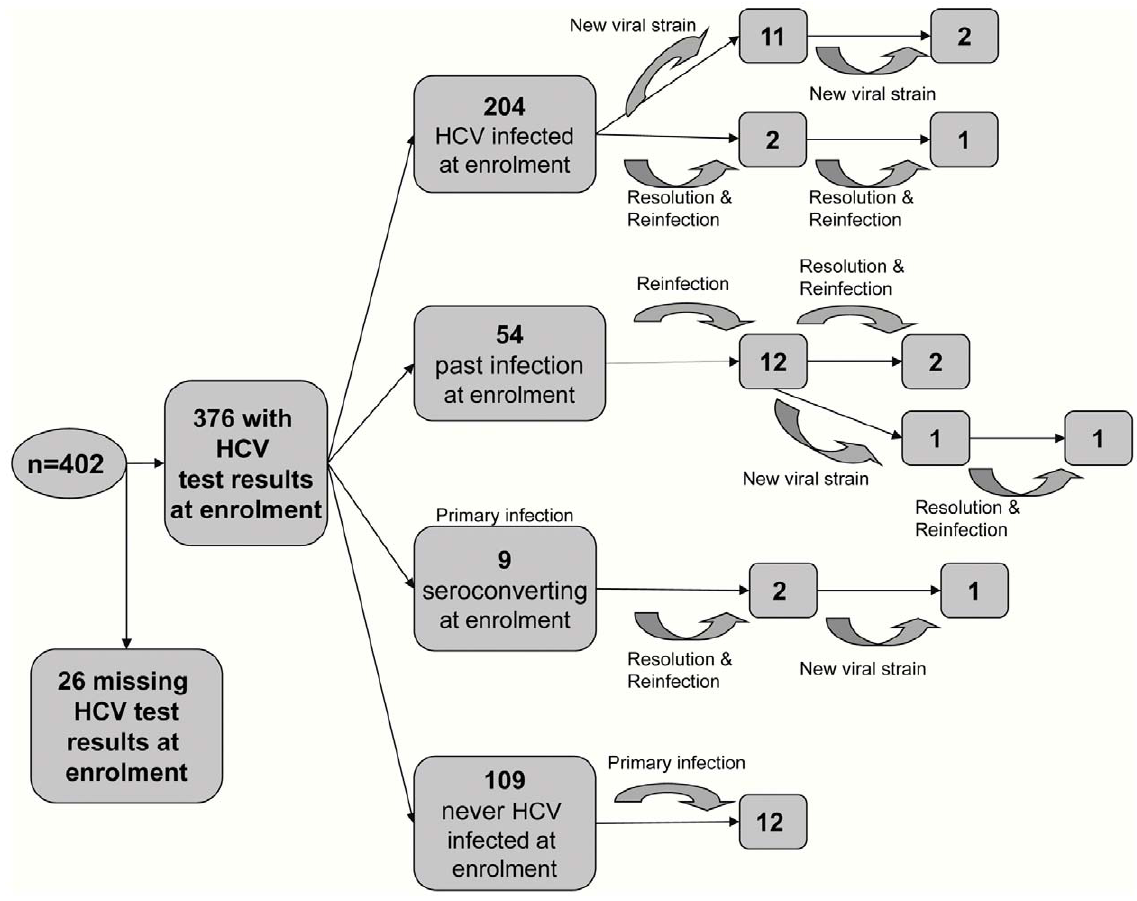
Figure 1. HCV primary infections, reinfections and changes in viral sequence by HCV status at study entry. HCV test results: anti-HCV and qualitative HCV RNA results. Those with missing results could not be bled or had indeterminate results; HCV infection at enrolment: anti-HCV positive and positive HCV RNA test (HCV RNA limit of detection: 50 IU/mL); past HCV infection at enrolment: positive anti-HCV test and negative HCV RNA test at the first study visit; seroconverting at enrolment: anti-HCV negative and positive HCV RNA test at the first study visit (indicating very early infection); never HCV infected at enrolment: negative anti-HCV test and negative HCV RNA test at first study visit. Participants with newly acquired primary HCV infection were defined by either: (a) a positive HCV RNA test and negative anti-HCV test at the first study visit (that is, seroconverting at enrolment); or (b) a negative HCV RNA test and negative anti- HCV test at their first study visit (that is, never infected at enrolment) and a subsequent positive anti-HCV/HCV RNA test during follow-up. Participants were defined as having a newly acquired reinfection if they tested HCV RNA negative on two occasions (at least 28 days apart) and subsequently tested HCV RNA positive; or tested HCV RNA positive and subsequently tested HCV RNA negative on one occasion, then tested HCV RNA positive, and the sequence distance between the two HCV RNA positive tests was at least 4% in the core region (331 nucleotides). Participants were defined as having a new viral strain if they did not satisfy the definition of reinfection because they had no intervening negative test but had two consecutive HCV RNA positive tests with sequence distance at least 4% in the core region (331 nucleotides). The methodology used to determine the 4% cut-off is described in the Materials and Methods section (definition 6).